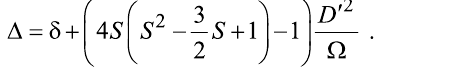
however, involves a virtual vibrational excitation. An exchange scattering process ( J ), which changes the Kramers’ subspace, cannot change the vibrational number at low energy [11]. This is why the two processes E ′ and J result only in a QST-Kondo side-peak in Figure 3, which is split at Ω and suppressed due to the inability to reach the vibrational ground-state. Only when a longitudinal spin-coupling D ′ is present as well, can the virtual vibrational excitation coherently reach the ground state and a full zero-bias QST-Kondo anomaly can develop, as the red curve in Figure 3 shows. One may say that due to the quantum fluctuations of the vibrational mode of the SMM, the magnetic symmetry is broken in virtual intermediate states, allowing for Kondo exchange scattering [12]. Therefore even for SMMs that have vanishing static E due to symmetry, spin-fluctuations